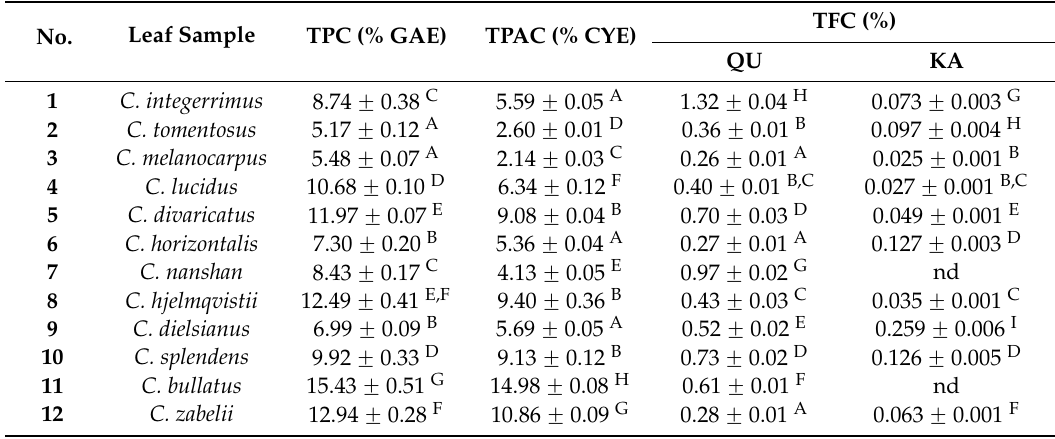
Table 2. Total phenolic (TPC), total proanthocyanidin (TPAC), and total flavonoid (TFC) contents in the Cotoneaster leaf extracts a .